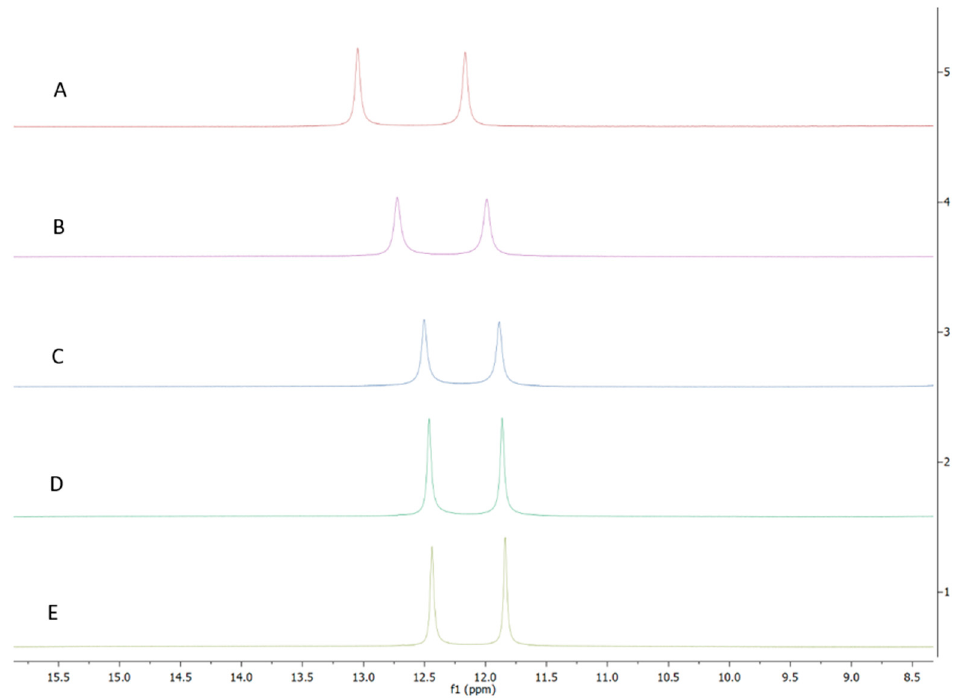
Figure 3. 1 H NMR spectra of AB-2-29 with (A) 0.0 (B) 0.5 (C) 1.0 (D) 2.0 (E) 4.0 equivalents of zinc. The shifting of the NH 2 peaks (between 11.5 and 13.0 ppm) with increased equivalents of zinc implies complexation between AB-2-29 and zinc.